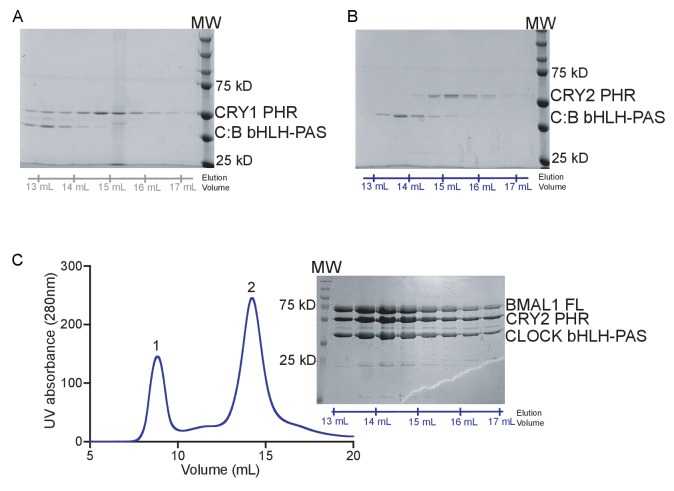
Gel filtration analysis of CRY1, CRY2 and CLOCK:BMAL bHLH-PAS proteins.(A) SDS-PAGE analysis of the peak fractions from the CRY1 PHR incubated with C:B bHLH-PAS (gray) injection on the S200 10/300 GL column (Figure 2A). Elution volume (mL) is marked below the gel. (B) SDS-PAGE analysis of the peak fractions from the CRY2 PHR incubated with C:B bHLH-PAS (blue) injection on the S200 10/300 GL column (Figure 2B). Elution volume (mL) is marked below the gel. (C) Chromatographic analysis of complex formation by CRY2 PHR and a heterodimer of CLOCK bHLH-PAS with full-length BMAL1, as above. The addition of the BMAL1 C-terminus resulted in co-elution of CLOCK:BMAL1 with CRY2 PHR in peak 2 (peak 1 contains aggregated protein eluting in the void volume).